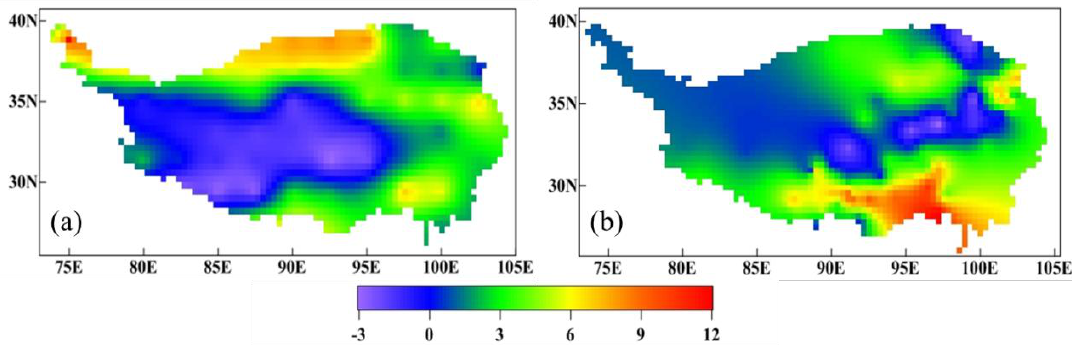
Figure 3. Spatial distribution of average temperature over the TP from 1980 to 2014 (°C) ( a ): equal- weighted ensemble average of the CMIP6; ( b ): station observation record.